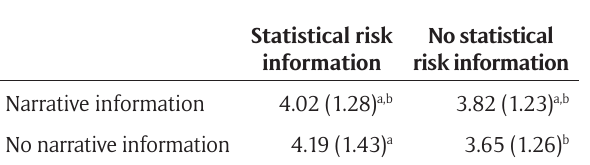
Table 1: Mean scores ( SD ) on susceptibility towards HPV (1–7; N = 375).